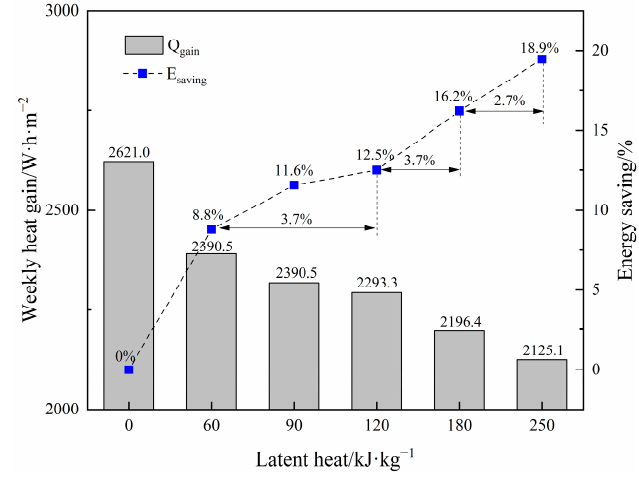
Figure 7. Heat gain and energy saving of PCM